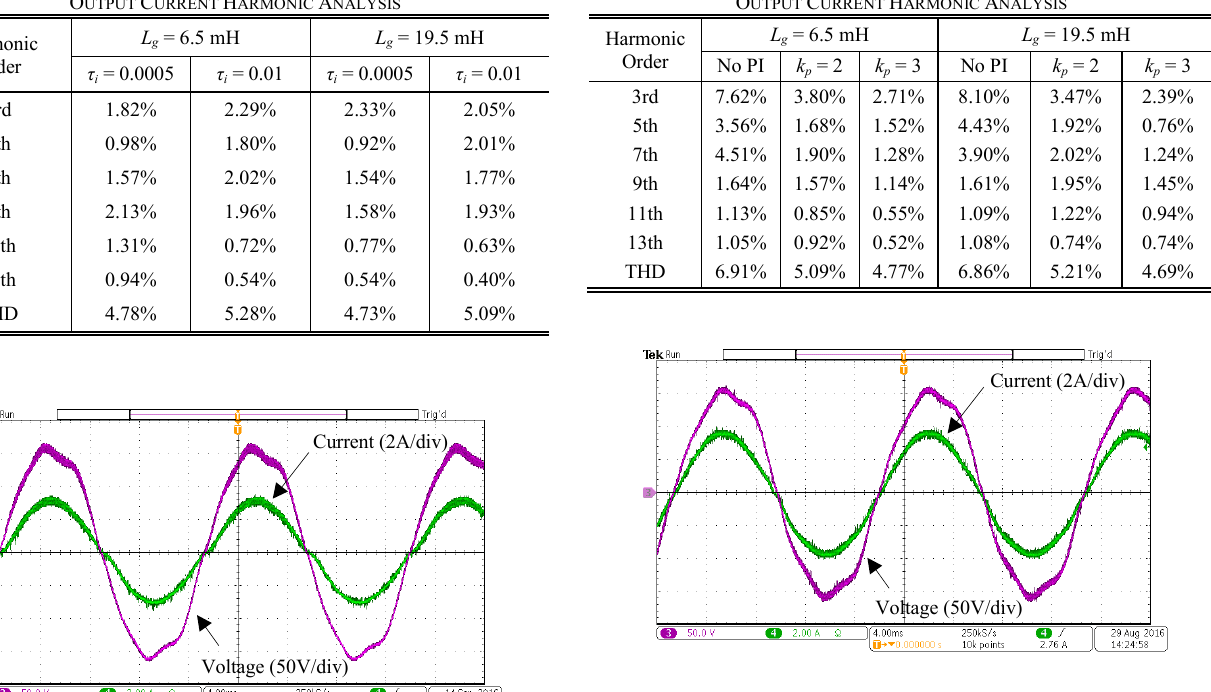
Fig. 21. Output voltage and output current when L g = 19.5 mH ( τ i = 0.0005)